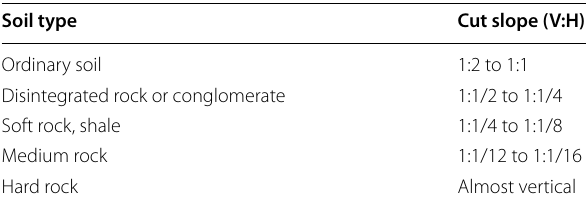
Table 1 Cut slopes for road excavation in Nepal Road Standard (DoR